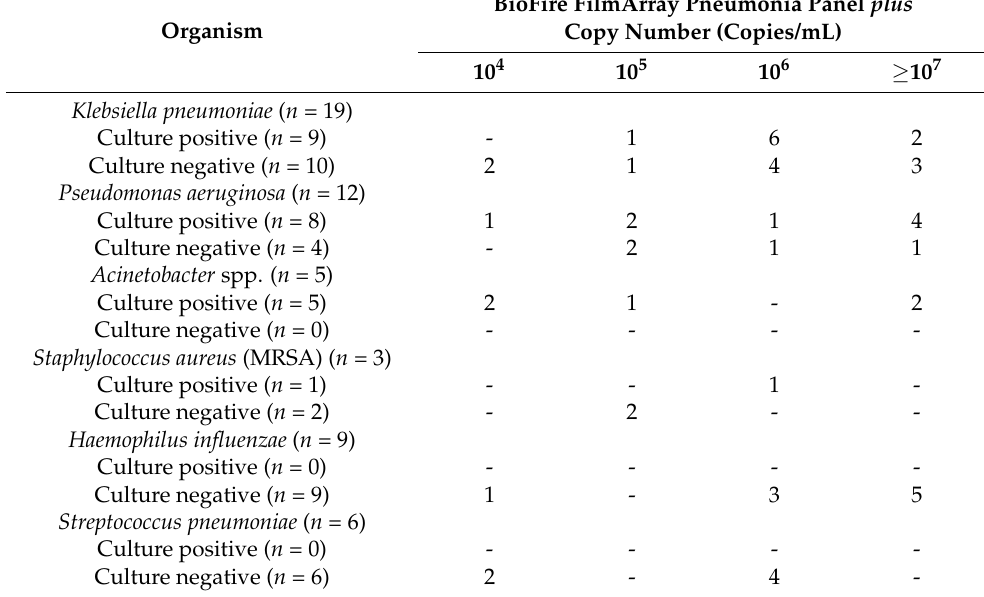
Table 4. Comparison between the distribution of bacterial copy number identified by the BioFire FilmArray Pneumonia panel plus in culture positive and negative cases for the specific type of the organism.